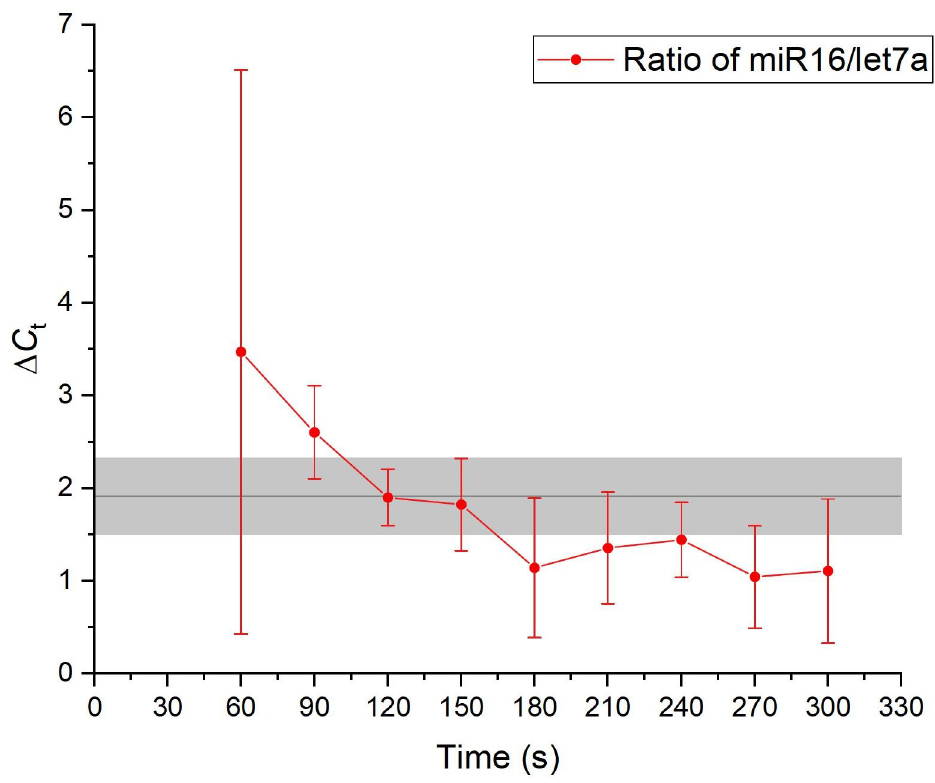
Fig 7. Time series for the on-chip gel-electrophoresis of kit extracted miRNA. The gray area denotes the ratio of miR16 to let7a in the input sample. The red data points are the ratio detected in the eluted fractions. Both the fractions at 120s and 150s display a ratio that is very close to the ratio of the input sample. This observation indicates that both miRNA species are eluted at the same rate (n =